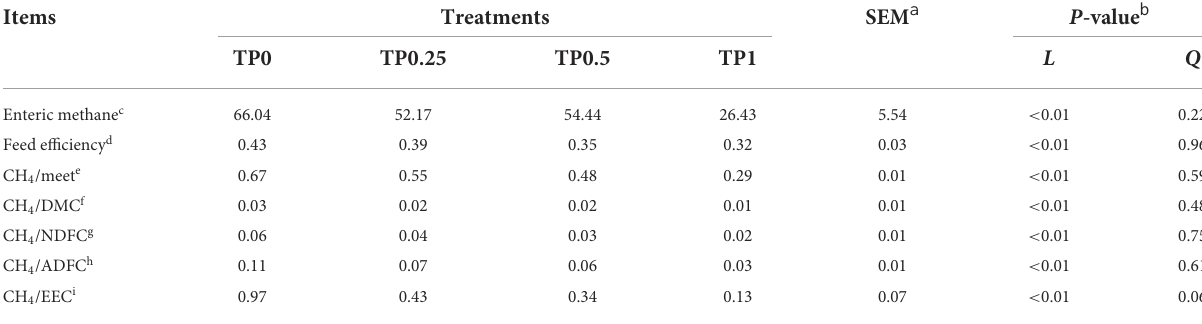
TABLE 3 Enteric methane production, feed efficiency, and estimates of emissions in female buffaloes supplemented with palm kernel